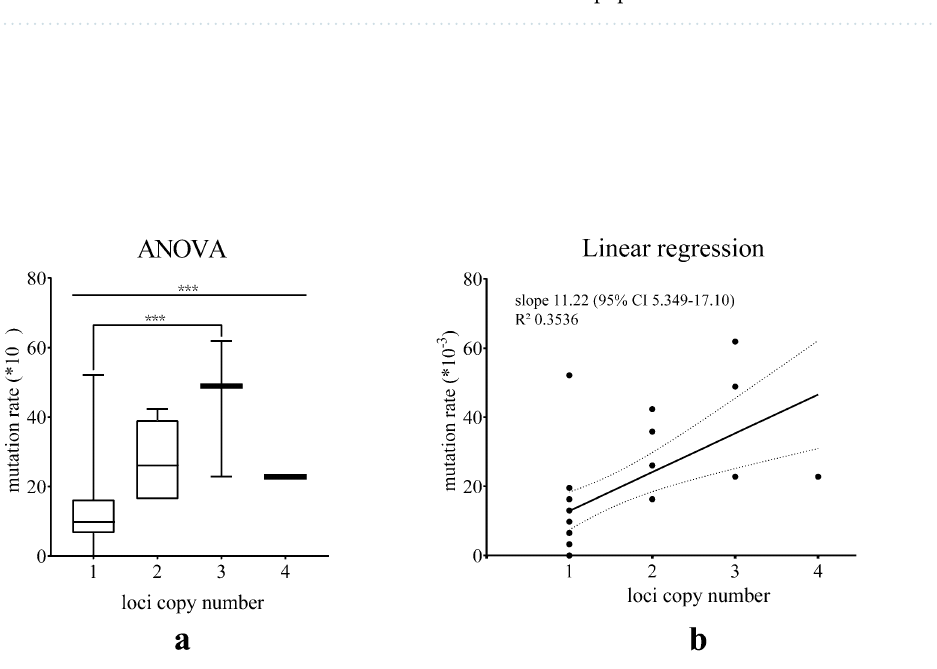
Table 1. Mutation information of the 30 Y-STRs in Chinese Han population. N: Number of mutation events.